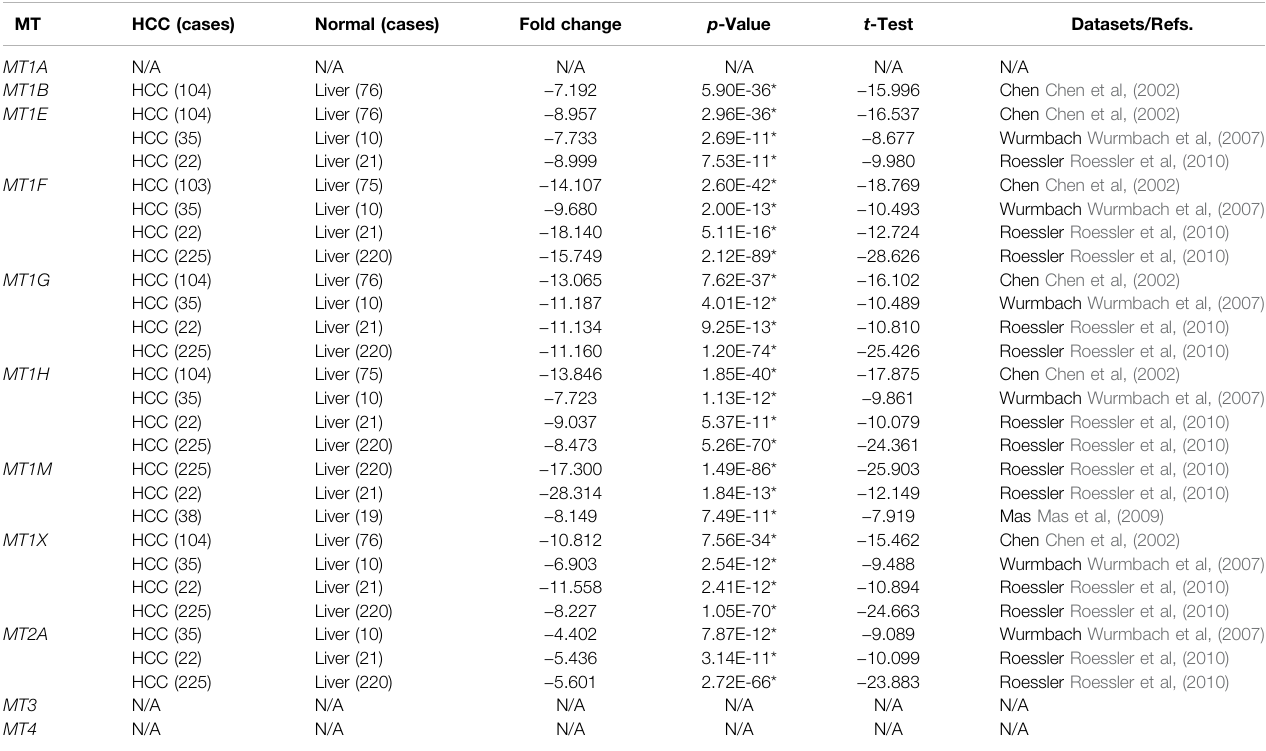
TABLE 1 | Datasets of MTs in HCC from the Oncomine